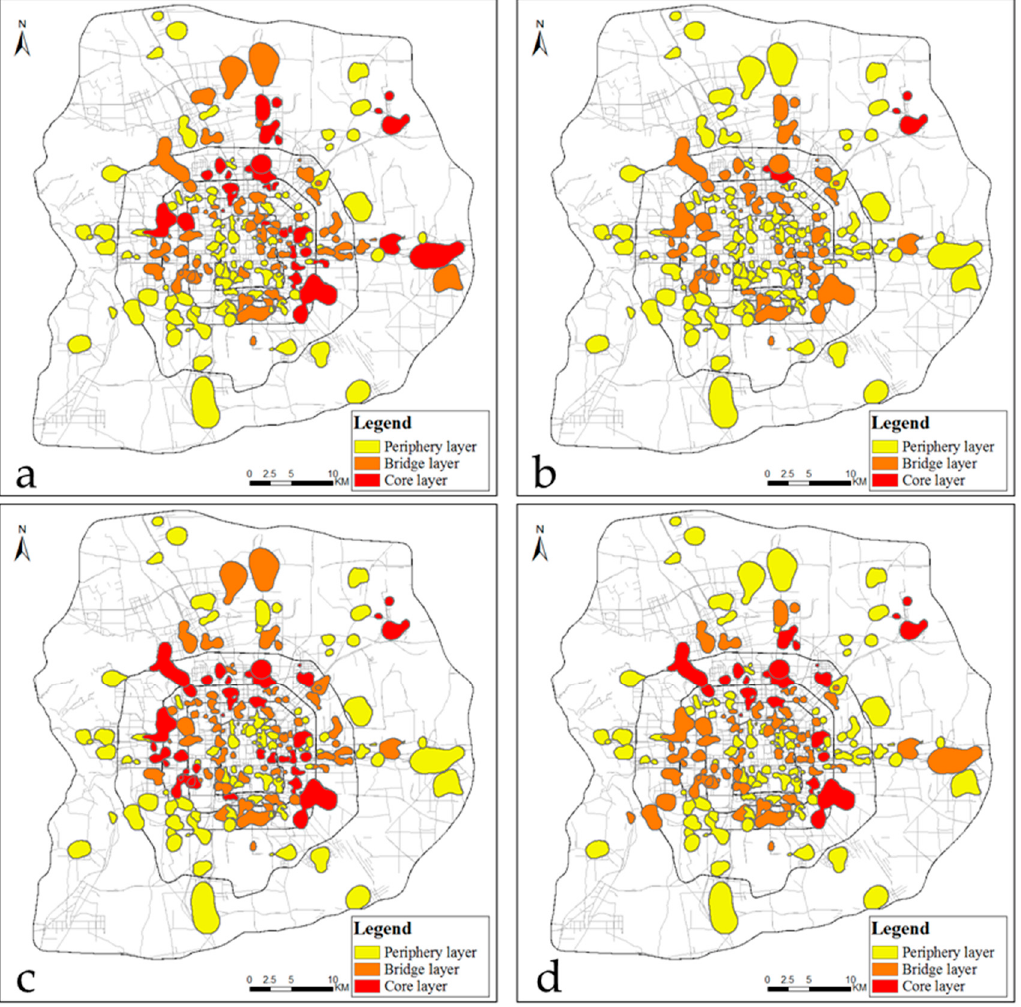
Figure 8. Distribution of all places in different periods in three layers on weekends. ( a ) Early morning; ( b ) morning; ( c ) afternoon; and ( d ) evening.